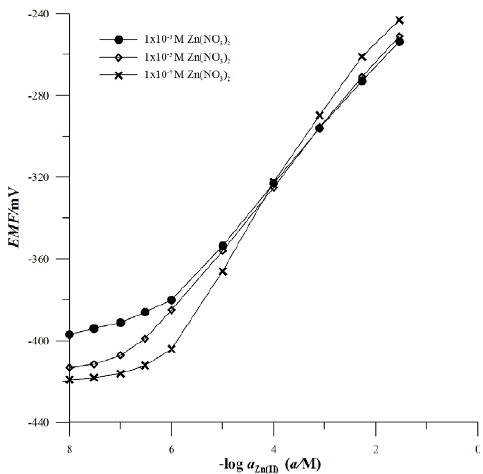
Figure 5. Potentiometric behaviour of blank electrodes in Zn(NO solution.